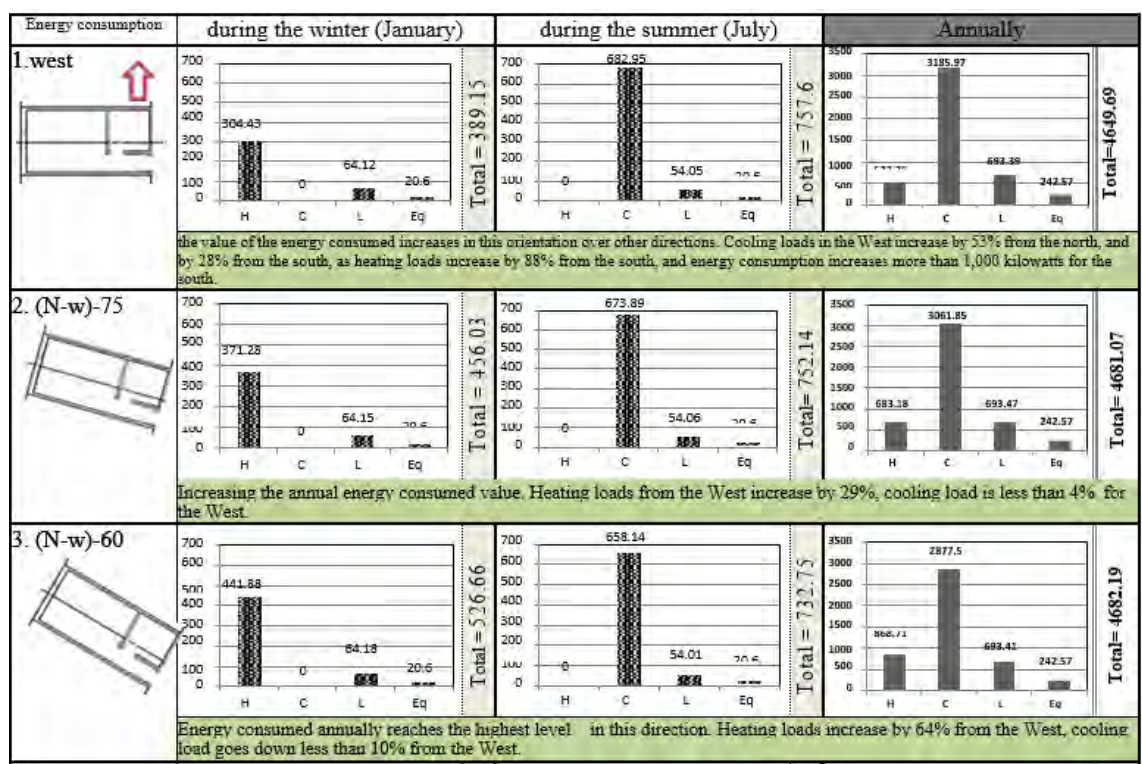
Table 6: Analysis of energy consumption in the directions (west + northwest) annually and during the summer and winter